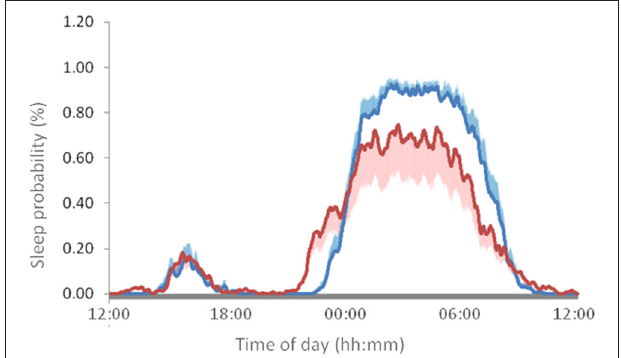
FIGURE 7 | Mean 24-h wave of sleep probability in patients with PD (red line) and healthy control subjects (blue line). The values represent the mean ± SEM for 15 subjects in each condition, monitored every 30s for 7 full